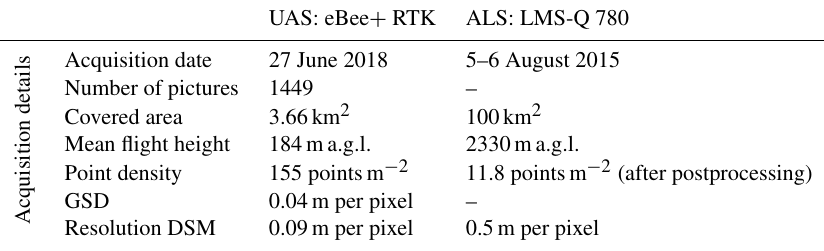
Table 2. Description of the summer datasets used for the calculation of the snow depth maps.